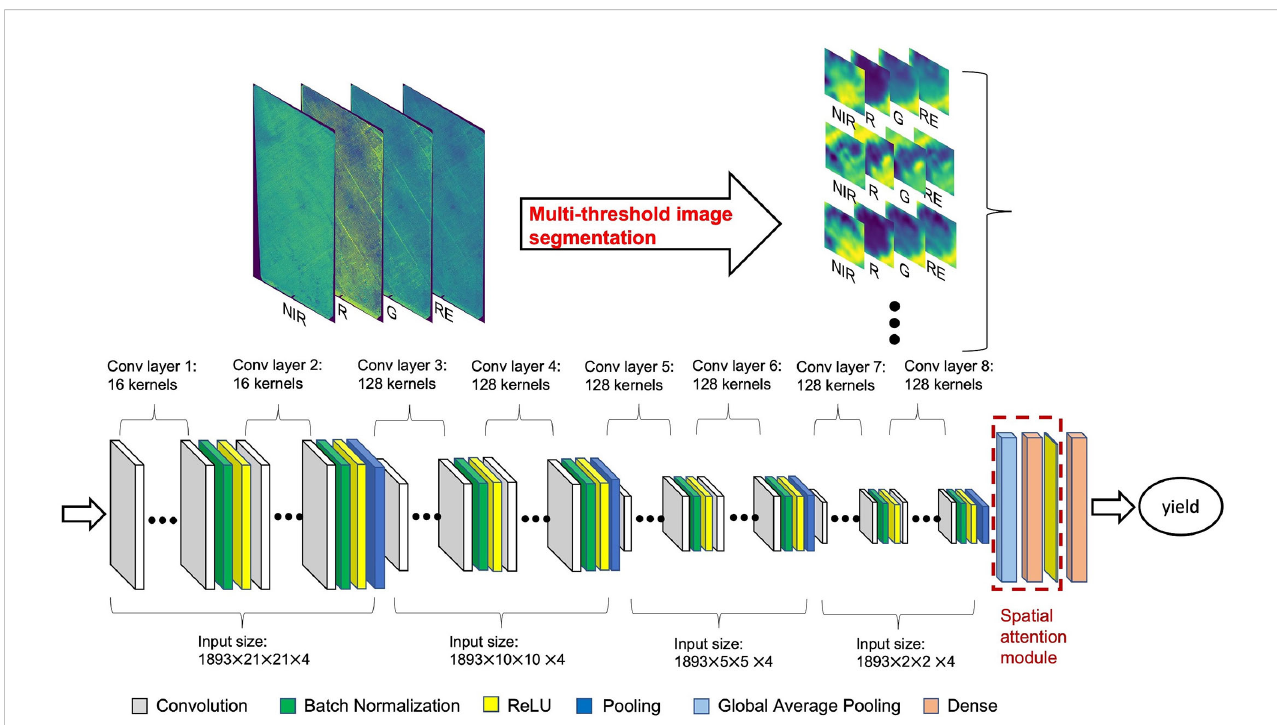
FIGURE 3 CNN model structure for tree-level yield estimation with multi-spectral aerial imagery. Input size represents total number of tree samples × image block height × image block width × number of bands. For each tree sample, an image block was clipped for each one of the four band imagery, with 21 by 21 pixels (at a 30cm resolution) centered at the identi fi ed tree center